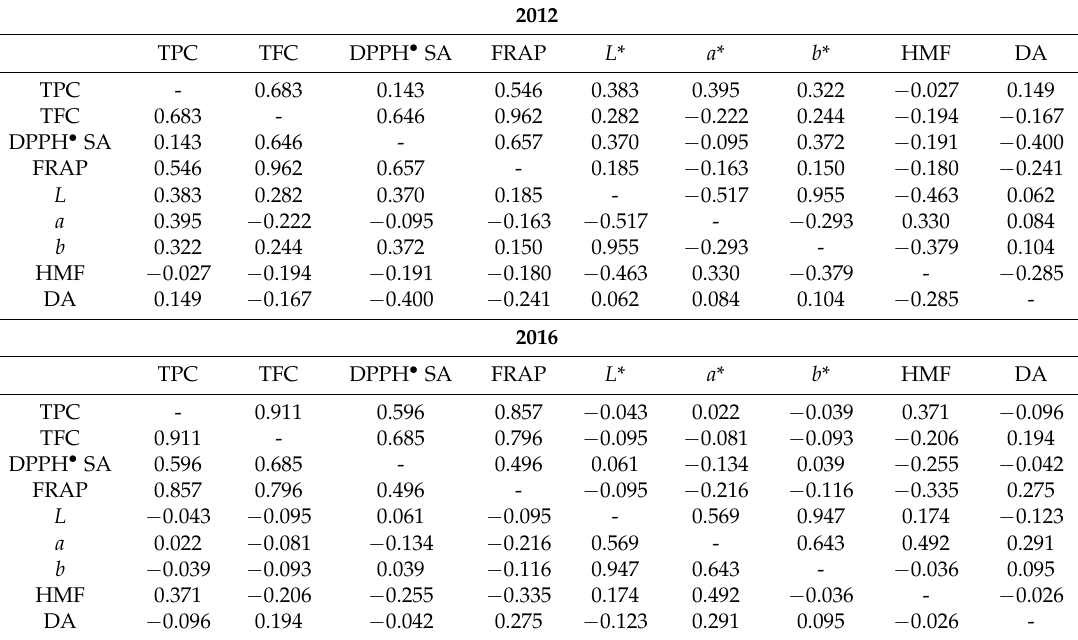
Table 4. Pearson correlation coefficients between TPC, TFC, DPPH • SA, FRAP, color parameters, HMF and DA for honey samples analysed in 2012 and 2016, expressed as p -levels (95% confidence